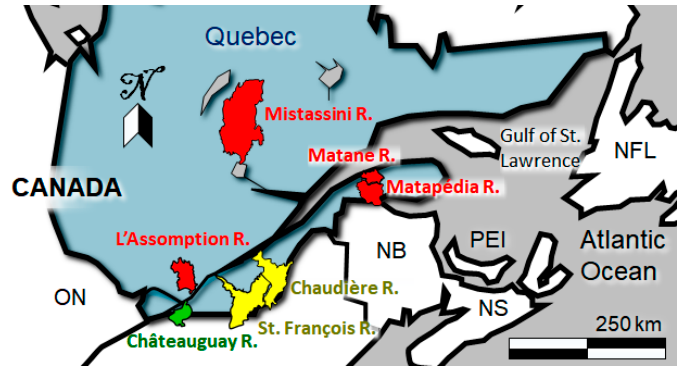
Figure 7. Spatial results showing a decline (green), stable conditions (yellow) or a rise (red) in the risk of ice-jam floods along seven rivers (here shown as watersheds) of Quebec. of ice-jam floods along seven rivers (here shown as watersheds) of